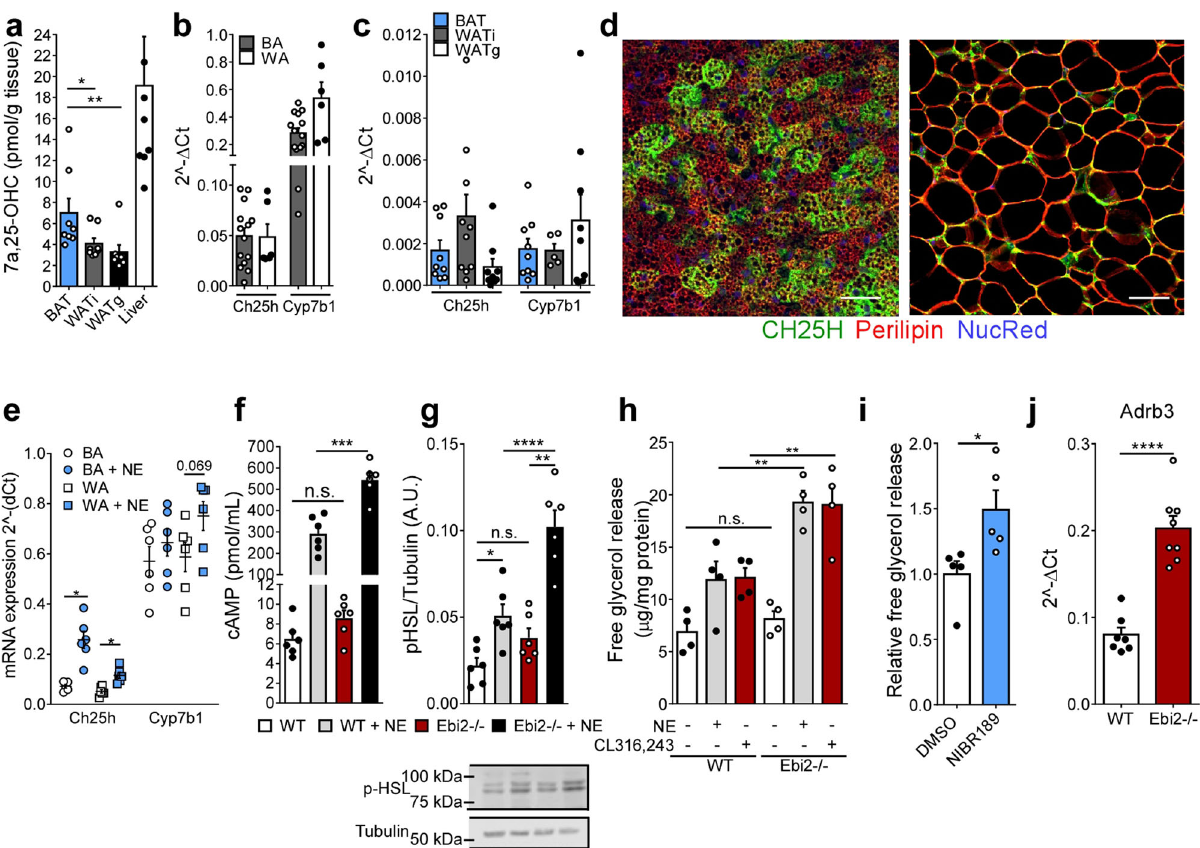
Fig. 2 The source of 7a,25-OHC and its autocrine effects on brown adipocytes. a 7 α ,25-OHC levels in BAT, WATi, WATg, and liver ( n = 8). b Ch25h and Cyp7b1 mRNA levels in brown and white adipocytes ( n = 5 – 14) c Ch25h and Cyp7b1 mRNA levels in ATs ( n = 10). d CH25H (green) and perilipin (red) stainings in BAT (left) and WATi (right) sections (Scale bar 50 µ M). e Ch25h and Cyp7b1 mRNA expression in brown and white adipocytes upon NE (1 µ M) treatment ( n = 5). f Intracellular cAMP levels in WT and EBI2 − / − brown adipocytes treated with NE (1 µ M) ( n = 6). g p-HSL representative immunoblot and relative quanti fi cation in WT and EBI2 − / − brown adipocytes treated with NE (1 µ M) ( n = 6). h Lipolysis of WT and EBI2 − / − brown adipocytes treated with NE (1 µ M) or CL316,413 (10 µ M) ( n = 4). i Lipolysis of WT brown adipocytes treated with NE (1 µ M) and NIBR189 (10 µ M) ( n = 5). j Adrb3 mRNA levels in WT and EBI2 − / − brown adipocytes ( n = 7 – 8). Mean ± s.e.m., one-way ANOVA with Tukey post-hoc test and Student ’ s t test, * p < 0.05, ** p < 0.01, *** p < 0.001, **** p <